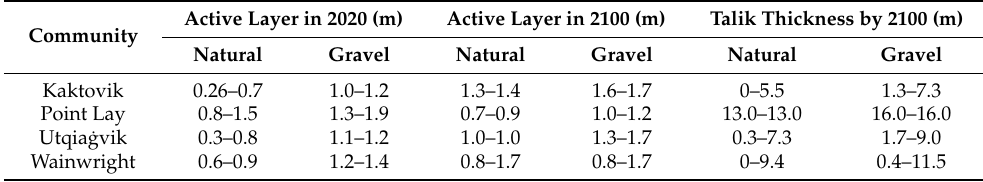
Table 3. Modeled increase in active layer thickness and subaerial talik formation between 2020 and 2100 (RCP 8.5) (adapted from [3]).